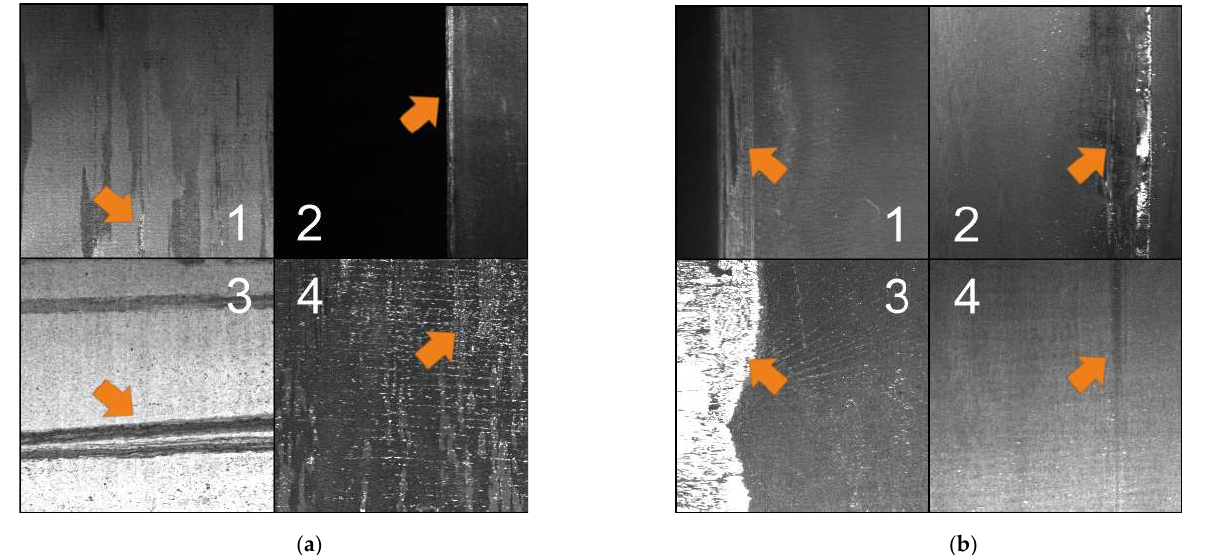
Figure 7. False positives ( a ) and false negatives ( b ) classification cases for Model 12. The main error rate is provided by false negatives (2.3% of all images, or 13.9%